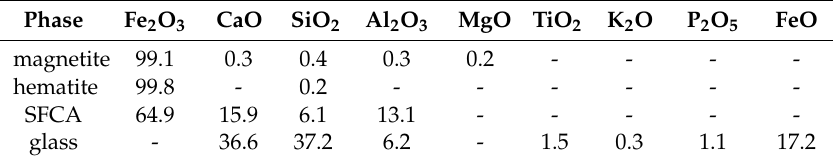
Figure 7. SEM micrographs of the SM-F sinter. B: CaO/SiO 2 , F: SFCA, G: glass, GE: gehlenite, H: hematite, M: magnetite, P: pore, Q: quartz, R: resin. Table 6. Average chemical composition of the secondary phases in SM-F sinter, wt %.